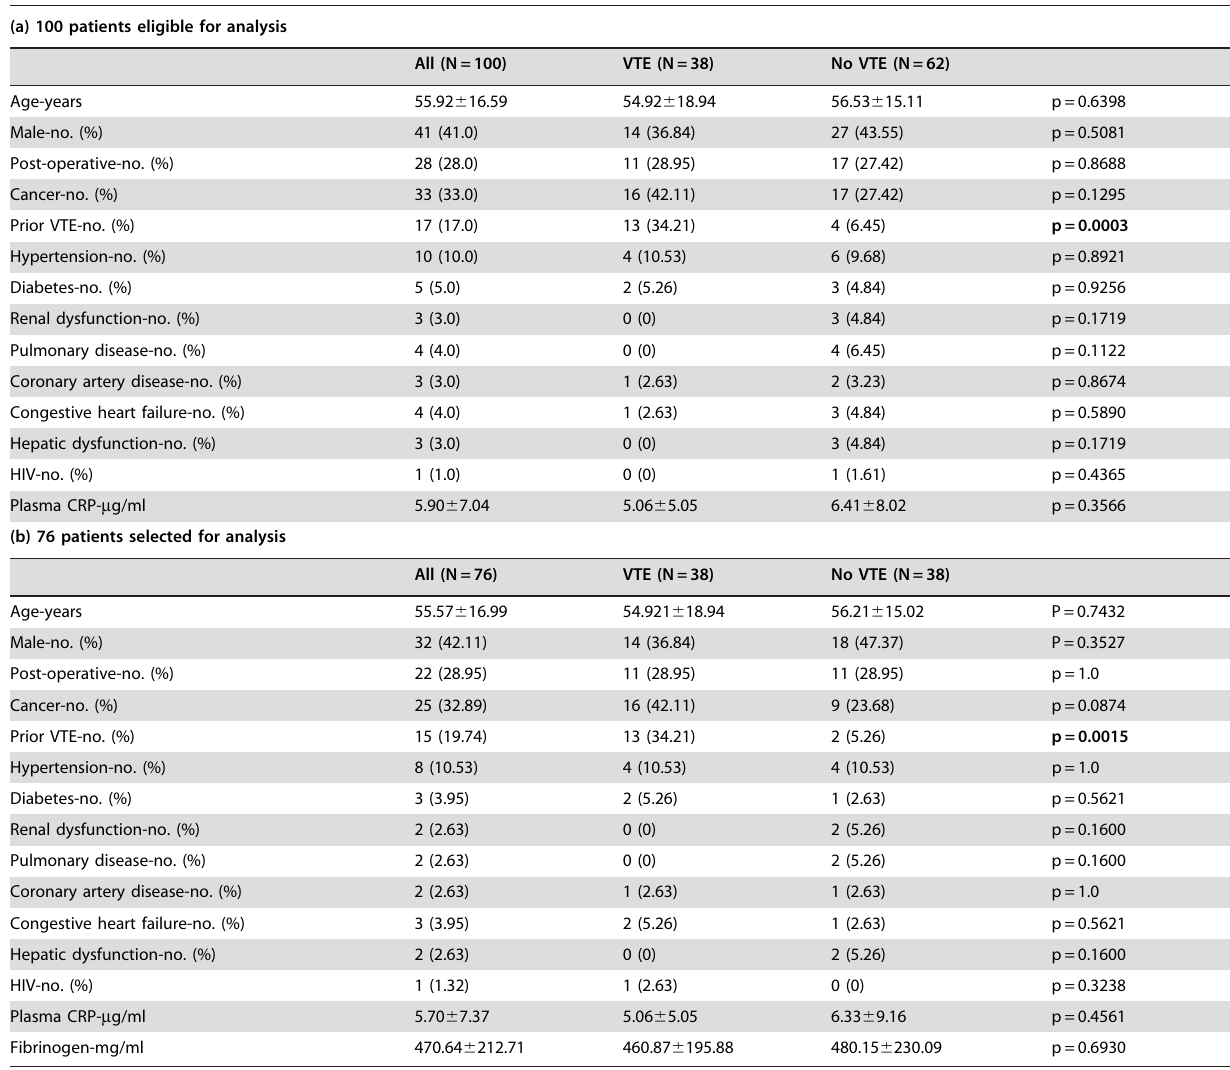
Table 1. Baseline characteristics of the patient cohort*. .. ... .... ... ... .... ... ... .... ... ... .... ... ... .... ... ... .... ... ... .... ... ... .... ... ... .... ... ... .... ... ... .... ... ... .... ... ... .... ... ... .... ... ... . (a) 100 patients eligible for